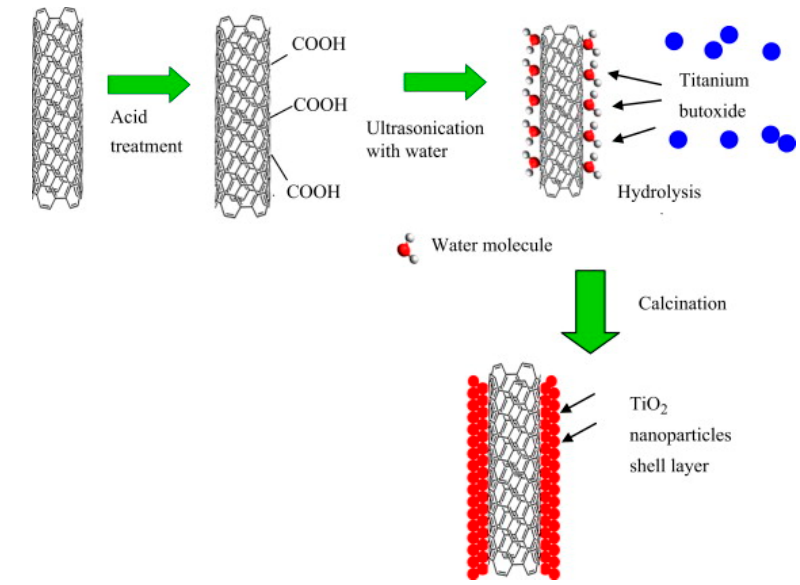
Figure 12. Enhanced visible light responsive MWCNT/TiO 2 core–shell nanocomposites for photocatalytic reduction of CO 2 . Reproduced from work in [102] . Copyright 2013 Elsevier B.V. photocatalytic reduction of CO 2 . Reproduced from work in [102]. Copyright 2013 Elsevier